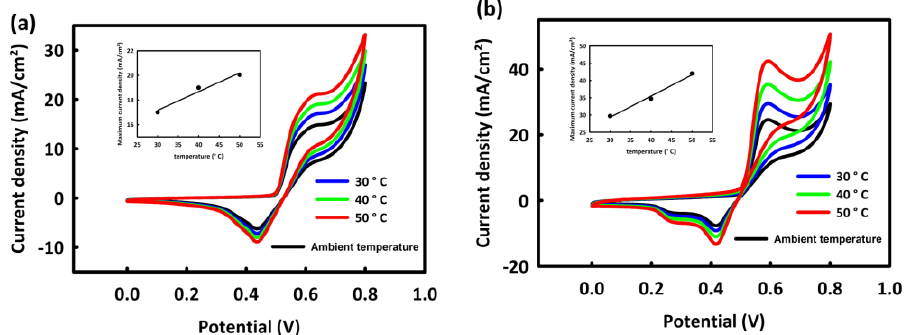
Figure 7. CV curves of MN ( a ) and MNR ( b ) at different temperatures.